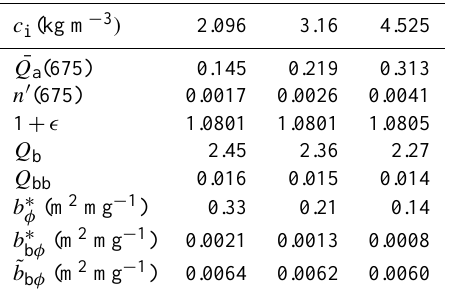
Table 3. Effect of variable c i on m and IOPs (510nm) of a popula- tion of vacuolate cells ( V g =50%).